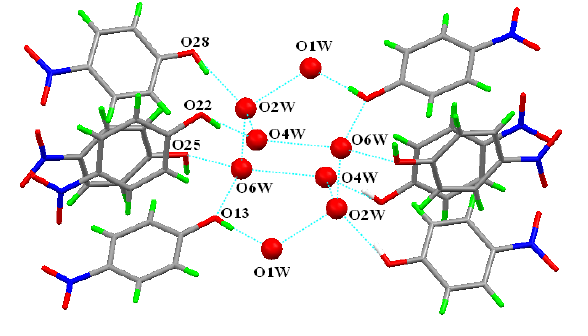
Figure 4 . Two different 4-nitrophenol assemblies(4a) A1 and (4b) A2